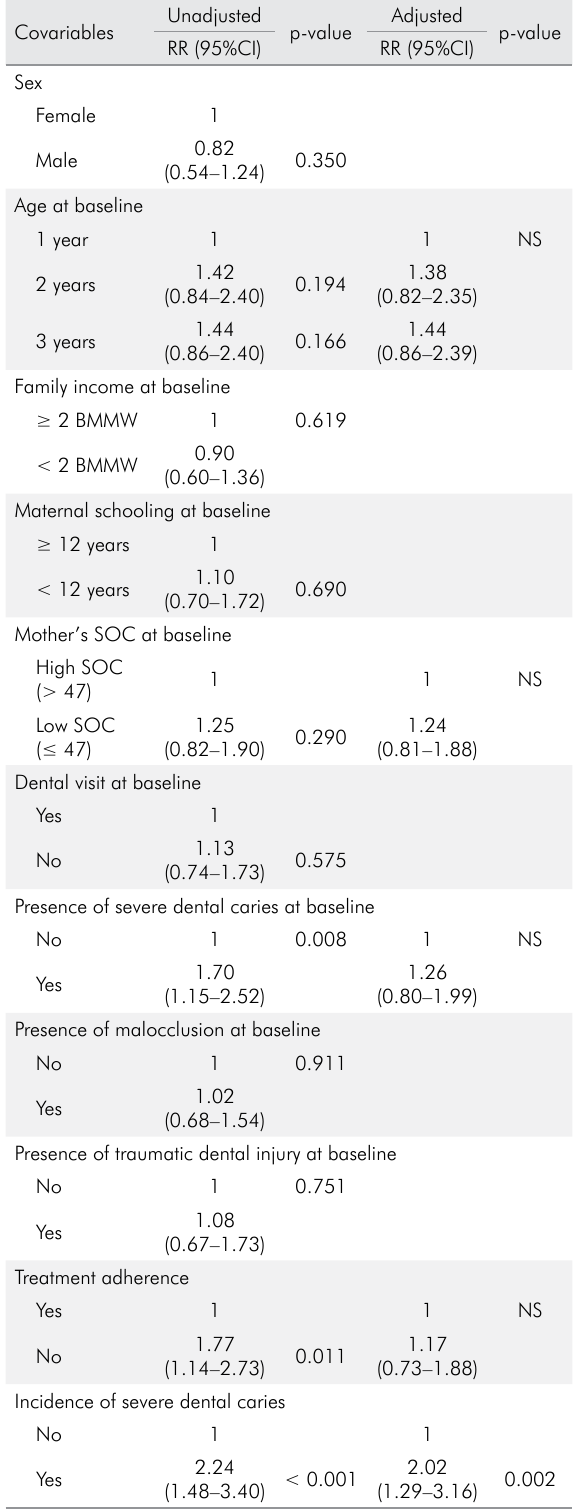
Table 3. Unadjusted and adjusted Poisson regression analyses between covariables and the decline in the B-ECOHIS